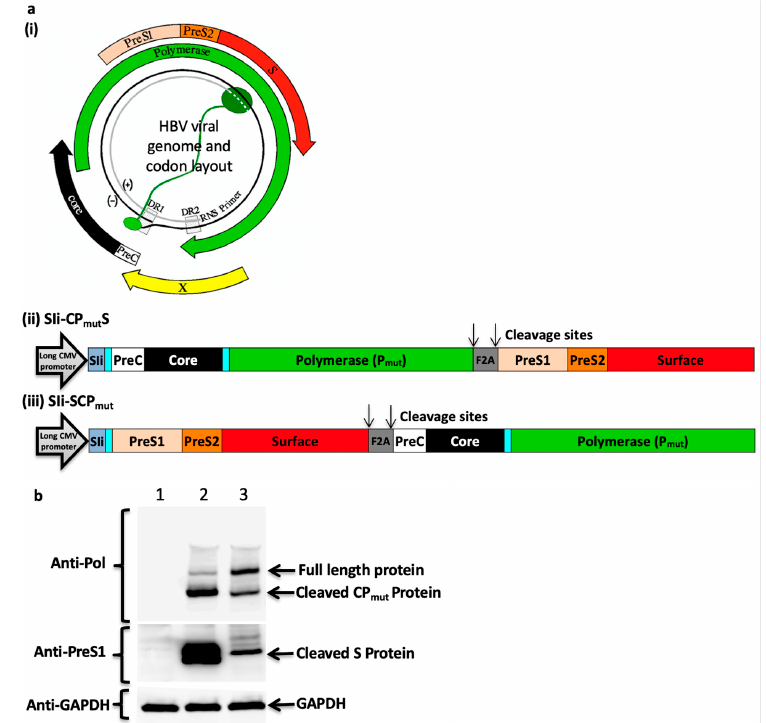
Figure 2. HBV immunogen design and in vitro protein expression analysis. ( a ) HBV viral genome and codon layout ( a, i ) (illustration from [25]). HBV genome comprise of a partially double stranded circular DNA, of approximately 3.2 kilobase (kb)